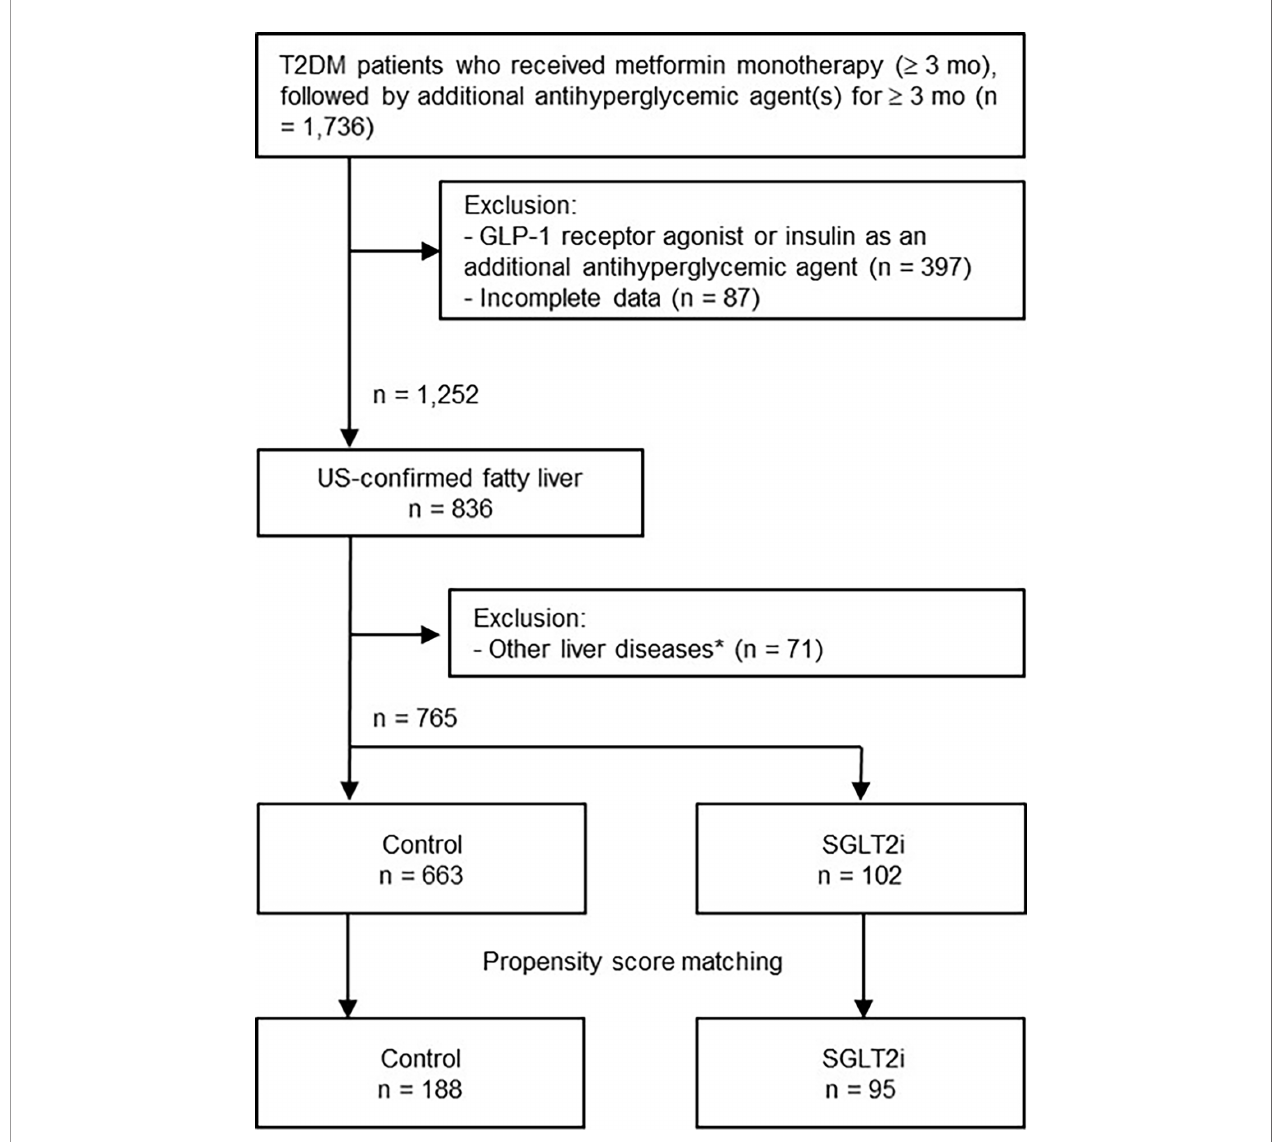
FIGURE 1 | Flowchart of the selection process. *Other liver diseases included viral hepatitis B and C, autoimmune hepatitis, drug-induced liver injury, and history of excessive alcohol intake (daily intake > 30 g for men and > 20 g for women). GLP-1, glucagon-like peptide-1; US, ultrasound; SGLT2i, sodium-glucose cotransporter-2